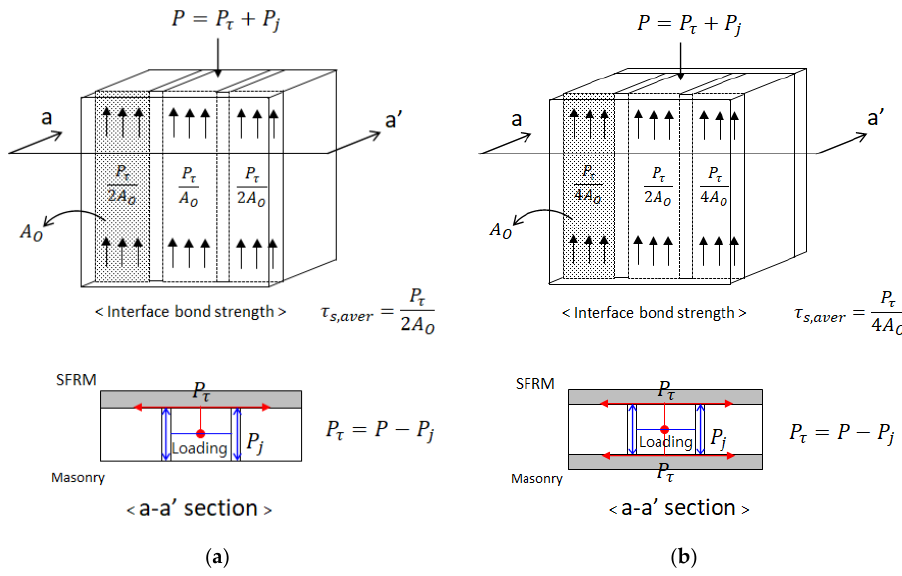
Figure 11. Transfer of test load through mortar joints and interface between masonry layer and AS-